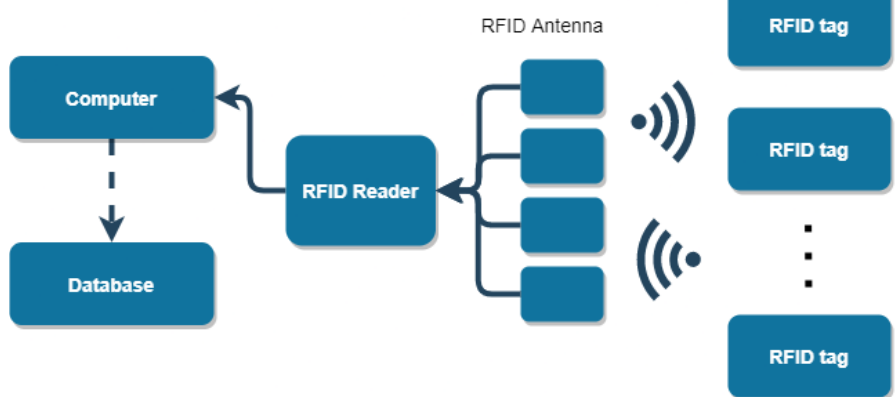
Figure 6. An illustration of an RFID system consisting of multiple RFID tags and an RFID reader connected to a computer managing a